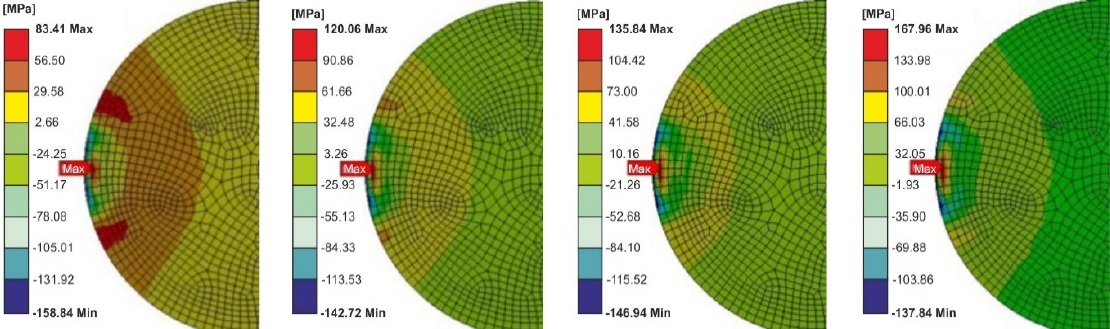
Figure 19. The Maximum Principal Stress in the adhesive joint for different calculations time (0.000084–0.00024 s) after taking into account the plastic properties of the upper element—Model 2 (nonlinear analysis).